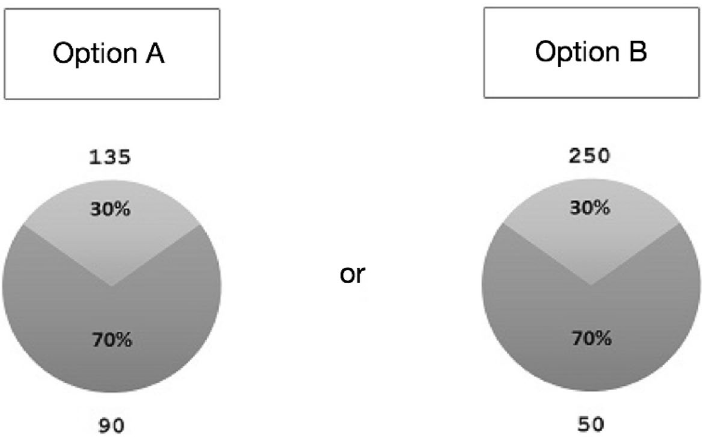
Figure 1. Task design. Subjects had to indicate their preferred option by pressing one of two buttons on the keyboard. The diagrams graphically and numerically present probability distributions for each lottery as well as the corresponding lottery outcomes (in monetary